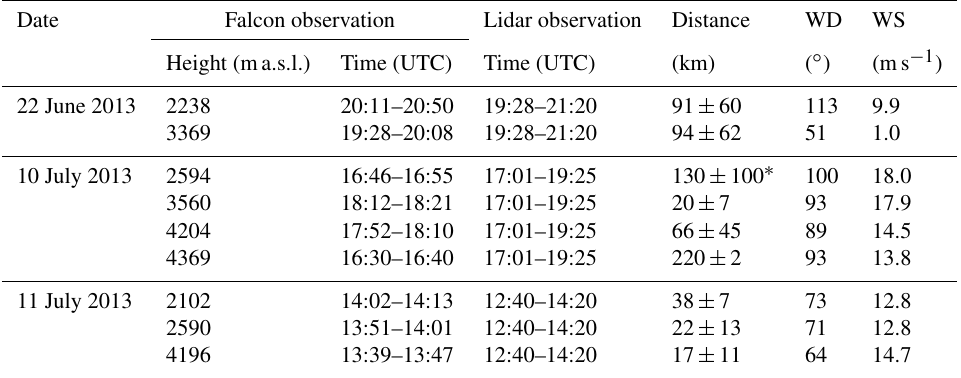
Table 4. Lidar and Falcon aircraft measurement periods. The mean distance (with standard deviation) of the Falcon from the lidar observation site is given. Local radiosonde launches provide the wind direction (WD) and wind speed (WS) at the altitude of Falcon aircraft. Date Falcon observation Lidar observation Distance WD WS Height (ma.s.l.) Time (UTC) Time (UTC) (km)